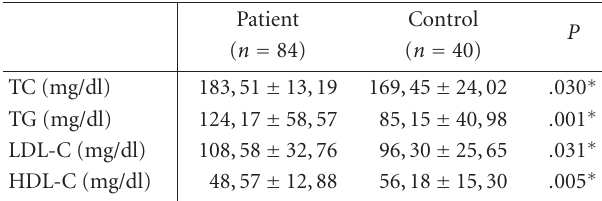
Table 2: Plasma lipids and lipoproteins in patients with psoriasis and control